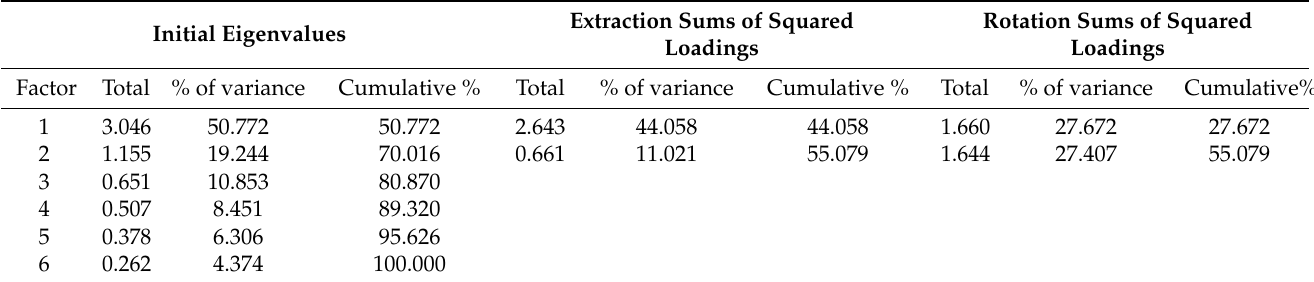
Table 5. Total variance explained obtained using the extraction method of maximum likelihood.